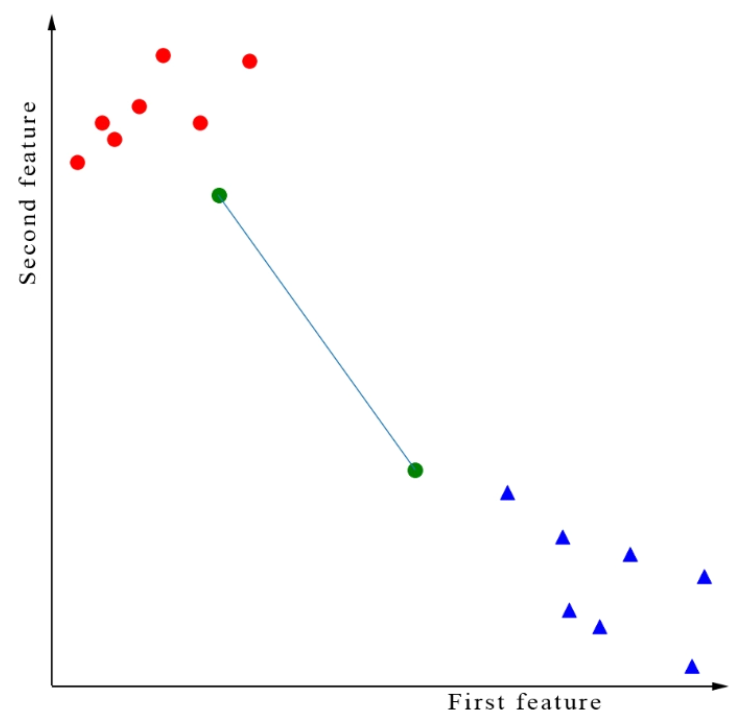
Figure 9. Update of shifting origin and shifting support direction vector using gradient descent